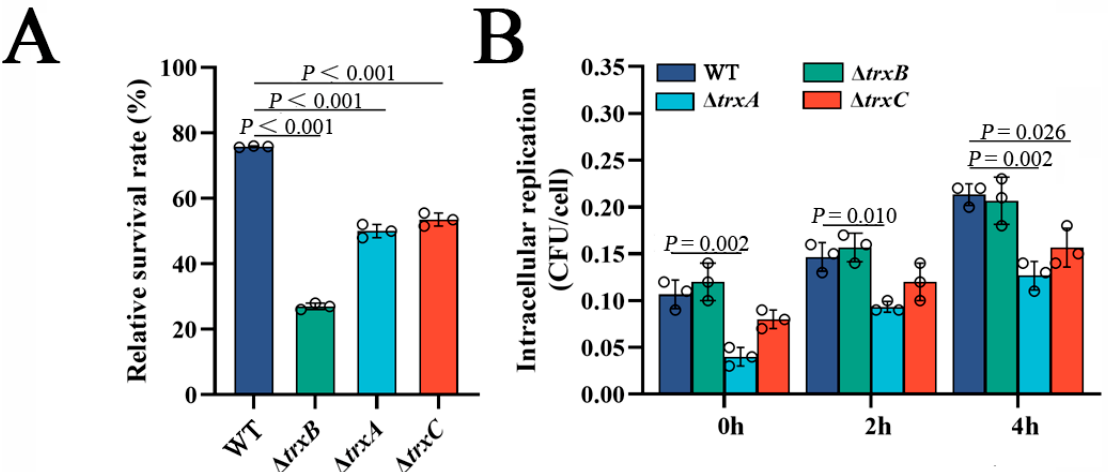
Figure 5. The effects of thioredoxin system mutations on bacterial survival in host serum and host macrophages. ( A ) The survival rate of WT, Δ trxB , Δ trxA and Δ trxC against non ‐ immune fish serum. Strains in the early logarithmic phase were incubated with non-immune tilapia serum or PBS (control) for 1 h. The number of viable bacteria was determined. ( B ) Edwardsiella piscicida replication in macrophages. The murine macrophage cell line RAW264.7 was incubated with WT, Δ trxB , Δ trxA and Δ trxC for 2 h. After killing and washing extracellular bacteria, the macrophages were cultured for different lengths of time. At each time point, the viable intracellular bacteria were determined. Data are presented as the means ± SEM (N = 3). N, the number of times the experiments were per ‐ formed. p values were obtained by analysis of variance using SPSS 23.